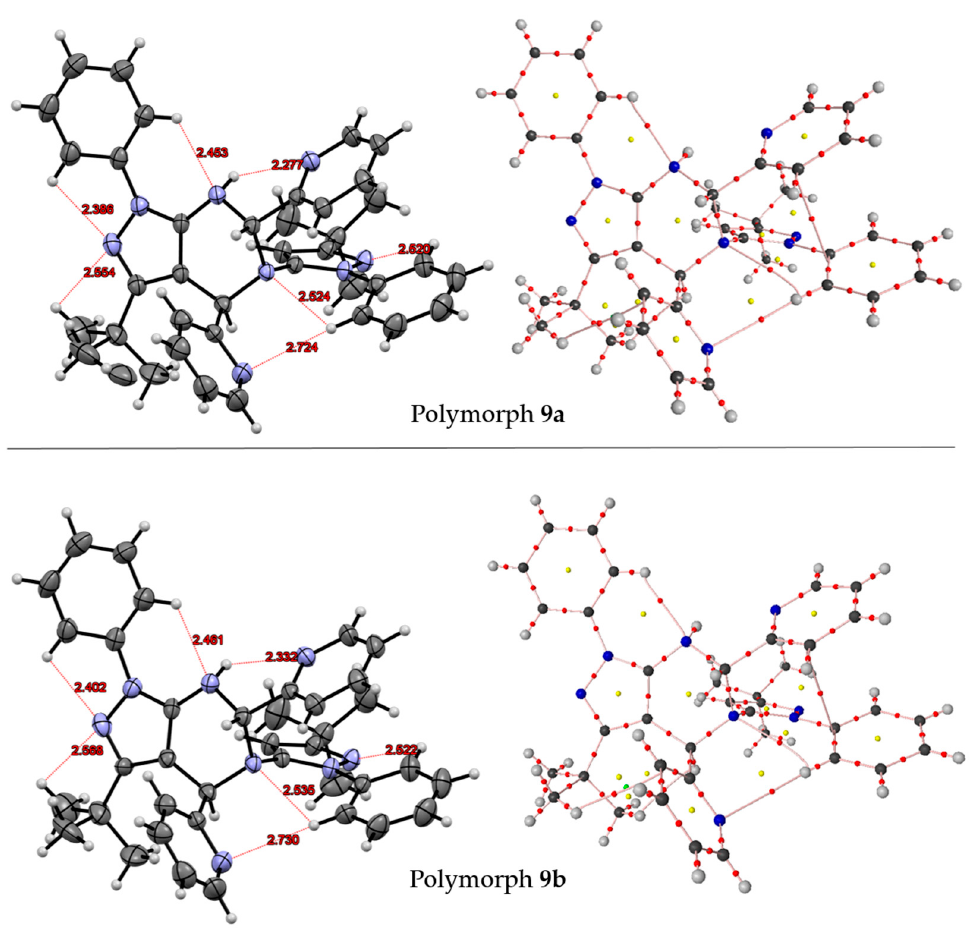
Figure 8. Comparison between molecular units extracted from crystals 9a and 9b . (Left) The 3D- ORTEP rendering of the molecular units showing intramolecular HB contacts as red dashed lines with distances in Å. Displacement ellipsoids are drawn with a probability level of 50%. (Right) Molecular graph for molecular units showing bond paths (pink lines), BCPs (red dots), RCPs (yellow dots), and CCPs (green dots).